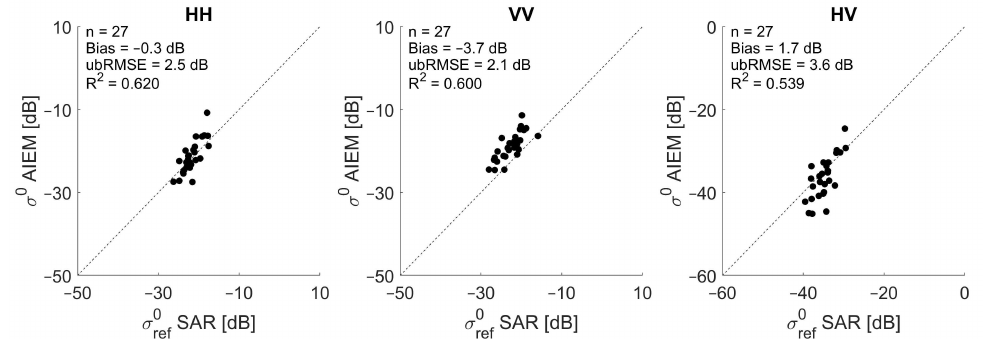
Figure 7. Simulated versus observed field average bare soil SAR backscatter for HH ( left ), VV ( middle ) and HV ( right ) polarization. Backscatter simulations are performed with the physically- based AIEM and in situ measured roughness parameters.